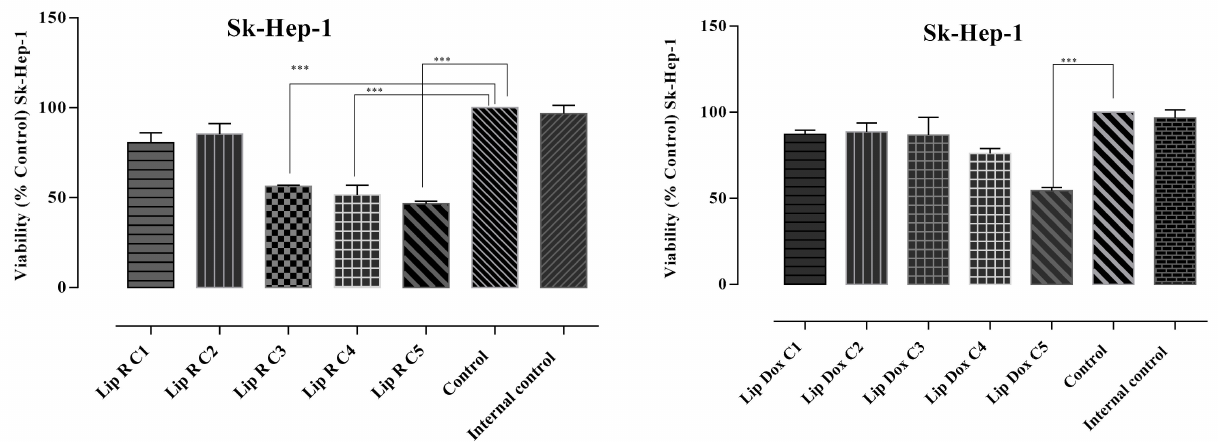
Figure 1. Antiproliferative potential towards SK-Hep-1 cell line induced by five different concentra- tions of L-R, calculated according to the TPC ( µ mol GAE/mL) determined for each extract (56.6 µ M, 113 µ M, 169.5 µ M, 226 µ M, and 282.5 µ M) and five different concentrations of L-DOX C1–C5 (1.64 µ M, 8.2 µ M, 12.3 µ M, 16.4 µ M, and 20.5 µ M). Negative control—untreated cells, internal control—L-E. Val- ues are represented as the mean of viability ± SD of three determinations. *** p < 0.0001 (differences between extract-treated cells and negative control, L-R versus negative control).